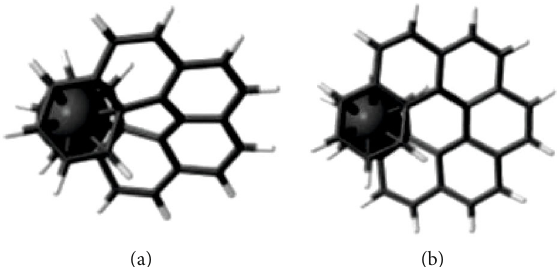
Figure 1: Illustration of the (a) silver-[6]helicene complex and the (b) silver-[7]helicene